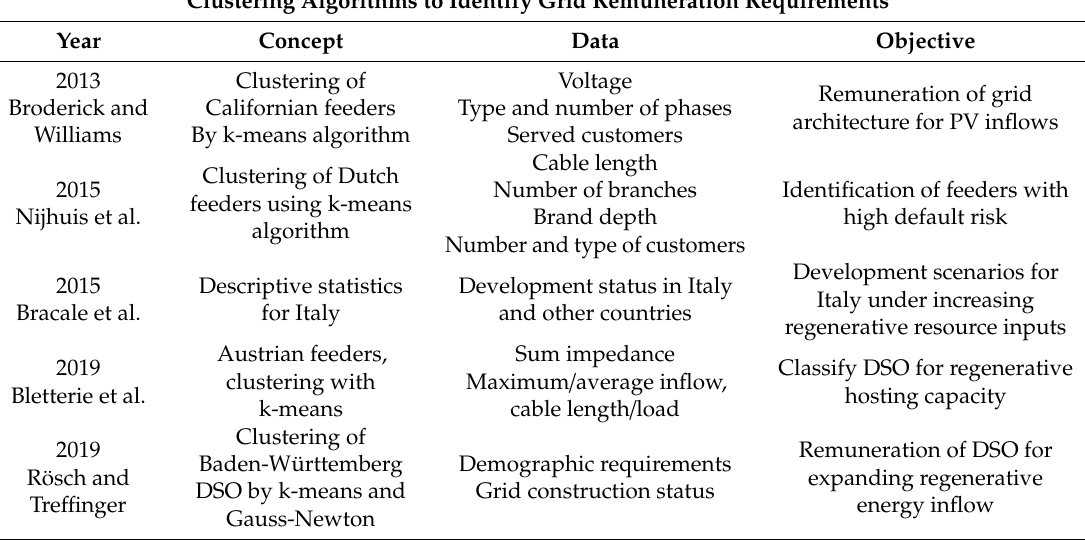
Table 1. Summary of previous studies using clustering algorithms for grid